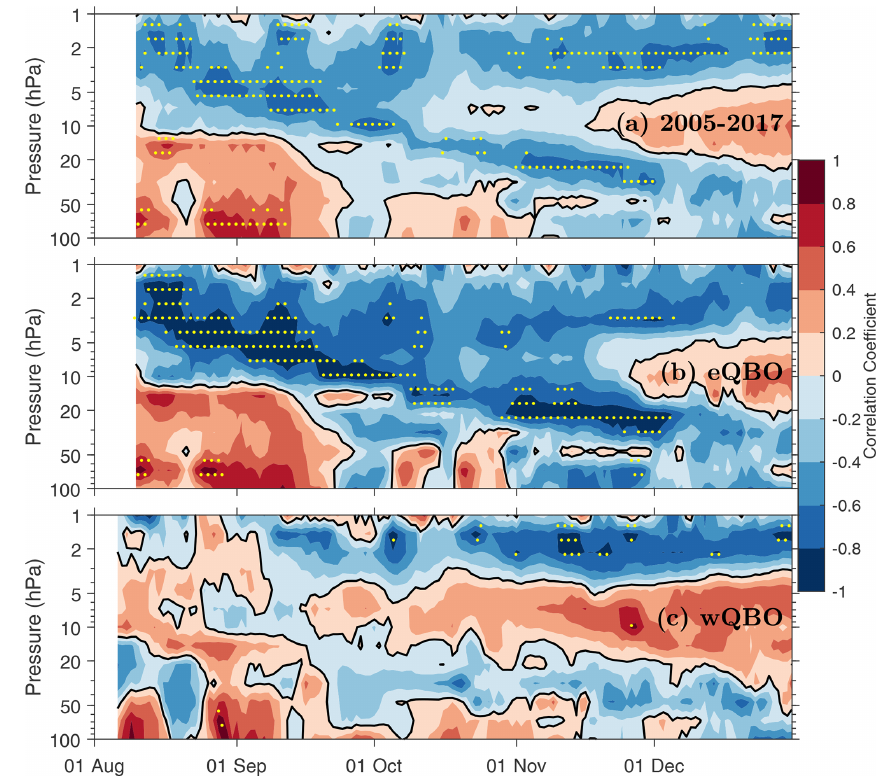
Figure 7. Correlation between (cid:99) Ap and the detrended daytime MLS ClO averaged over 60–82 ◦ S weighted by cos ( latitude ) for (a) all years, (b) eQBO years, and (c) wQBO years. The y axis is the pressure from 100 to 1hPa, and the x axis is the time from 1 August to the end of December. The coloured contours show the correlation coefficient with a contour interval of 0.2, and the black line indicates the zero contour. Stippling indicates statistical significance ( p ≤ 0 .